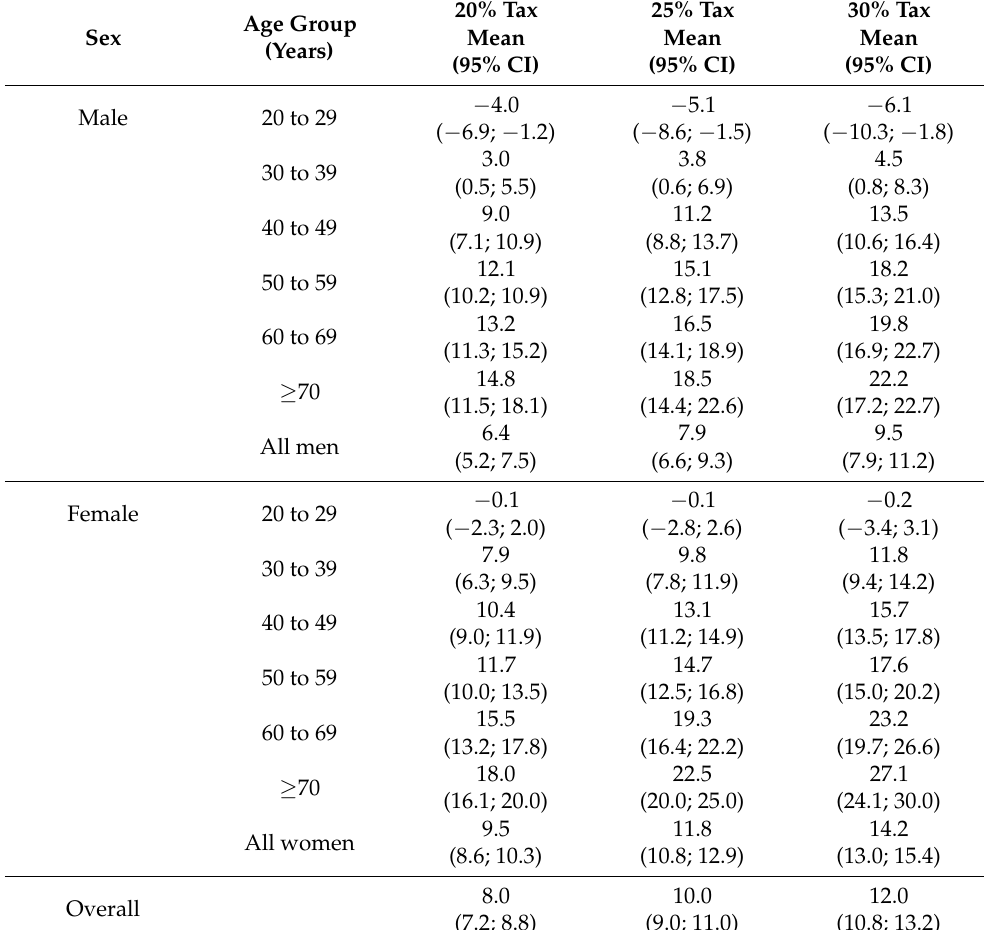
Table 1. Estimated mean change in calorie intake (kcal/person/day) in the three taxation scenarios according to sex and age